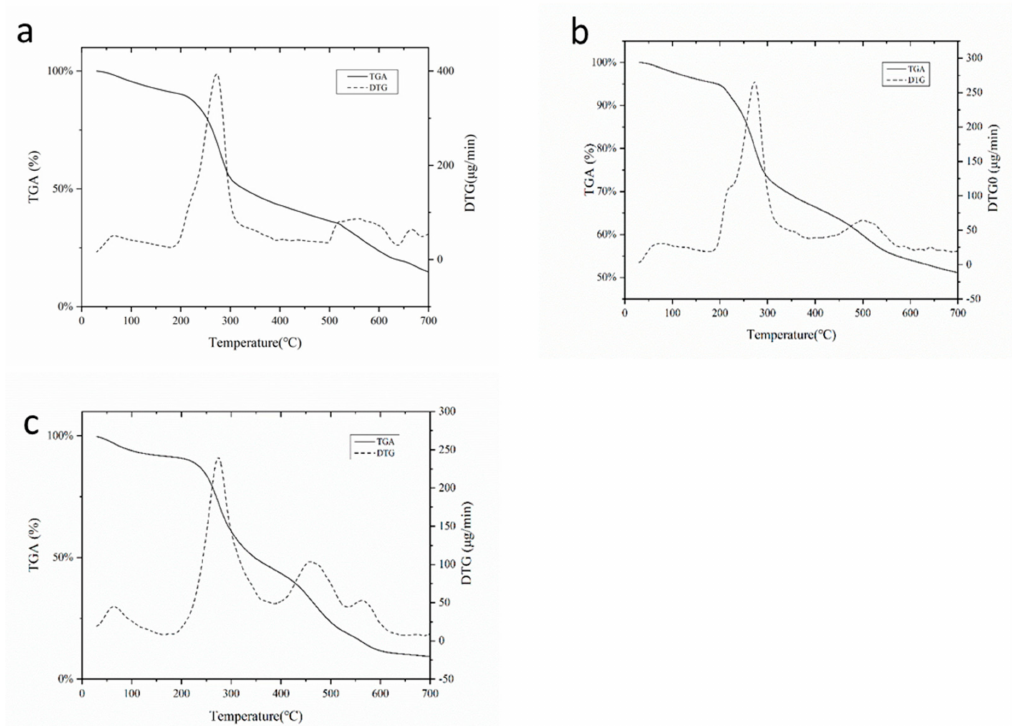
Figure 3. Thermogram of starch–alginate based beads: ( a ) starch-alginate beads ( b ) starch-alginate- kaolin beads ( c ) starch-alginate-rice husk powder